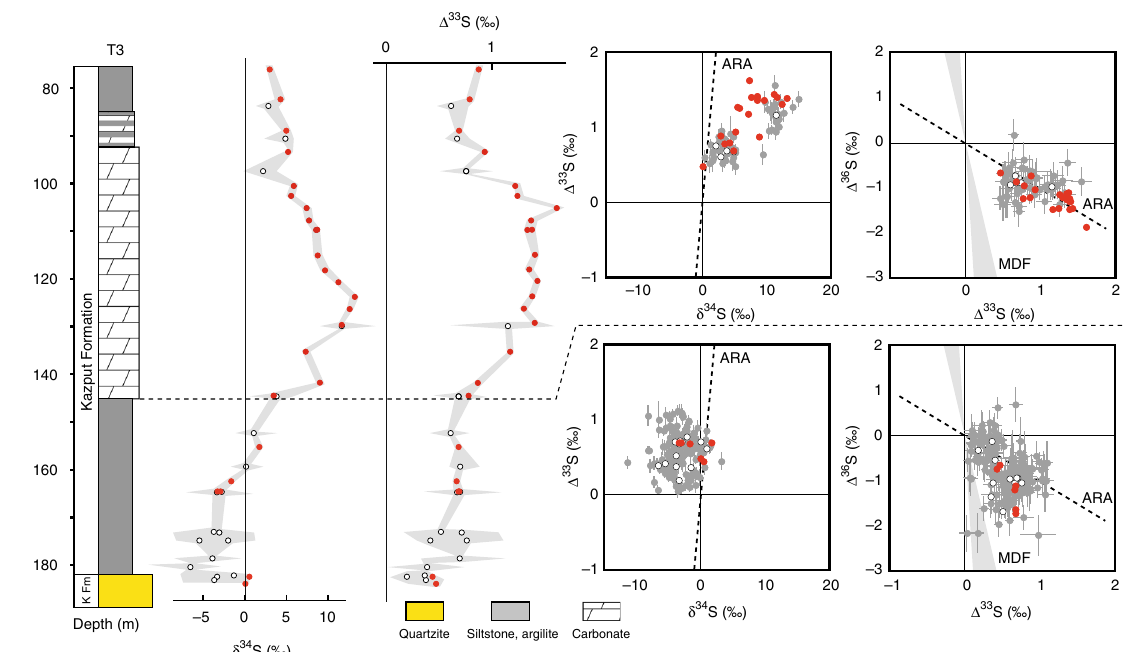
Fig. 4 δ 34 S and Δ 33 S pro fi les of sulphides in drill core T3 and associated δ 34 S- Δ 33 S and Δ 33 S- Δ 36 S compositional diagrams. Red dots, bulk analysis; white dots, mean value of in situ analysis for each sample; grey dots, individual spot analysis using the SHRIMP-SI (error bars are standard deviation of 1 σ , see Methods). The grey shaded areas in the δ 34 S and Δ 33 S pro fi les represent the range of individual spot analysis for each sample. ARA, Archaean Reference Array, MDF, mass-dependent fractionation of sulphur isotopes, KFm, quartzite of the Koolbye Formation. The stratigraphic column below 145 m depth corresponds to the domain (ii) discussed in the text and shown in Fig. 2